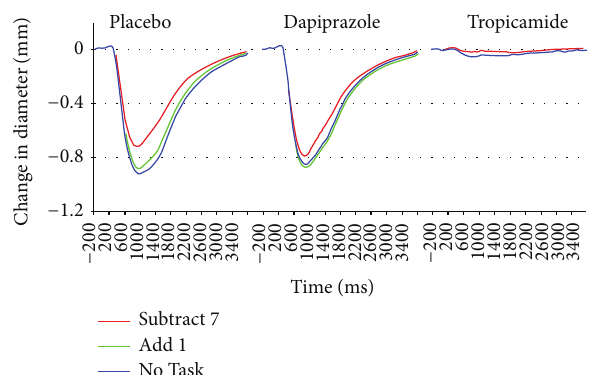
Figure 2: Same data as Figure 1, with initial diameters subtracted and scale increased. Note reduction of the light reaction for the Subtract7conditioninboththeplaceboanddapiprazoleconditions. For the dapiprazole administration, the data for the No Task and Add 1 conditions are nearly identical and are completely superimposed as a single line in the tropicamide condition with No Task condition overlaying the Add 1 data